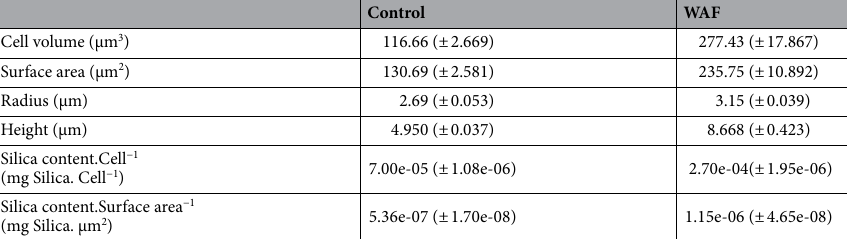
Table 1. Cellular morphology of T. pseudonana . Table summarizing morphological parameters such as cell volume, cell surface area, radius, height, silica content per cell and surface area of T. pseudonana cells grown under Control and WAF conditions (n = 3).